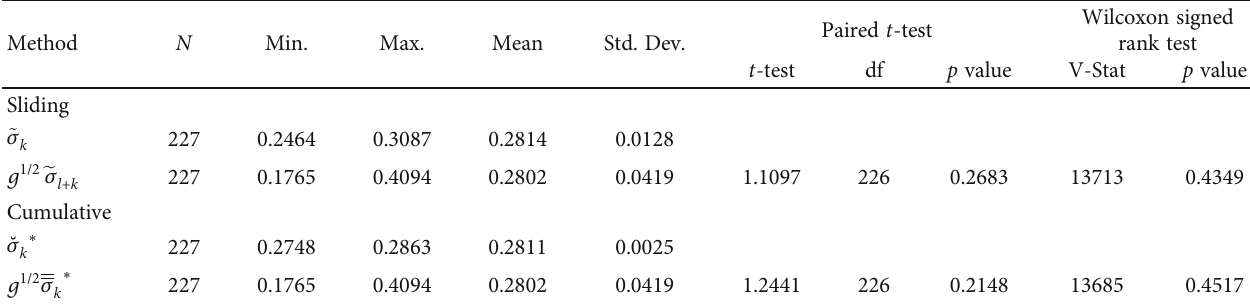
Table 1: Descriptive statistics and paired sample tests of the traditional and proposed methods. Method